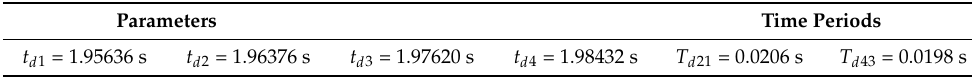
Figure 24. The time graph of acceleration by diagnostic part crossing over the simulated damage: ordinate tick marks: 100 ms − 1 , processed in DeweSoft. ordinate tick marks: 100 ms − 1 , processed in DeweSoft. Table 9. Time periods and their parameters according to Figure